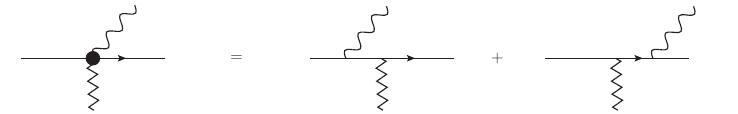
( p , p , p (cid:96) , p ¯ (cid:96) ) defined in Eq. (2) µ i o